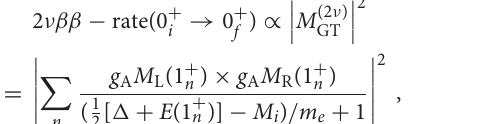
116 triplet. Shown are the 0 + ground state of the initial nucleus 116 Cd, the 0 + =